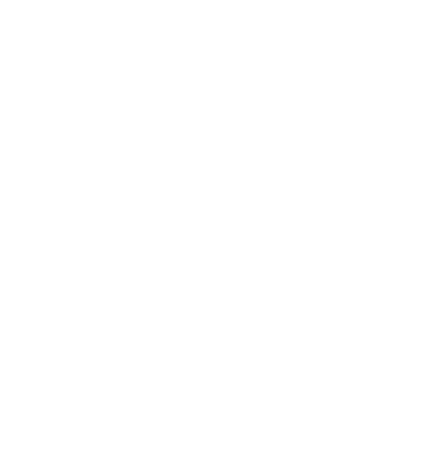
Figure 8. FTIR spectra of thermal decomposition product of E-HS-20 at several representative tem- 321 Figure 8. FTIRspectra ofthermal decompositionproductofE-HS-20 atseveral peratures. 322